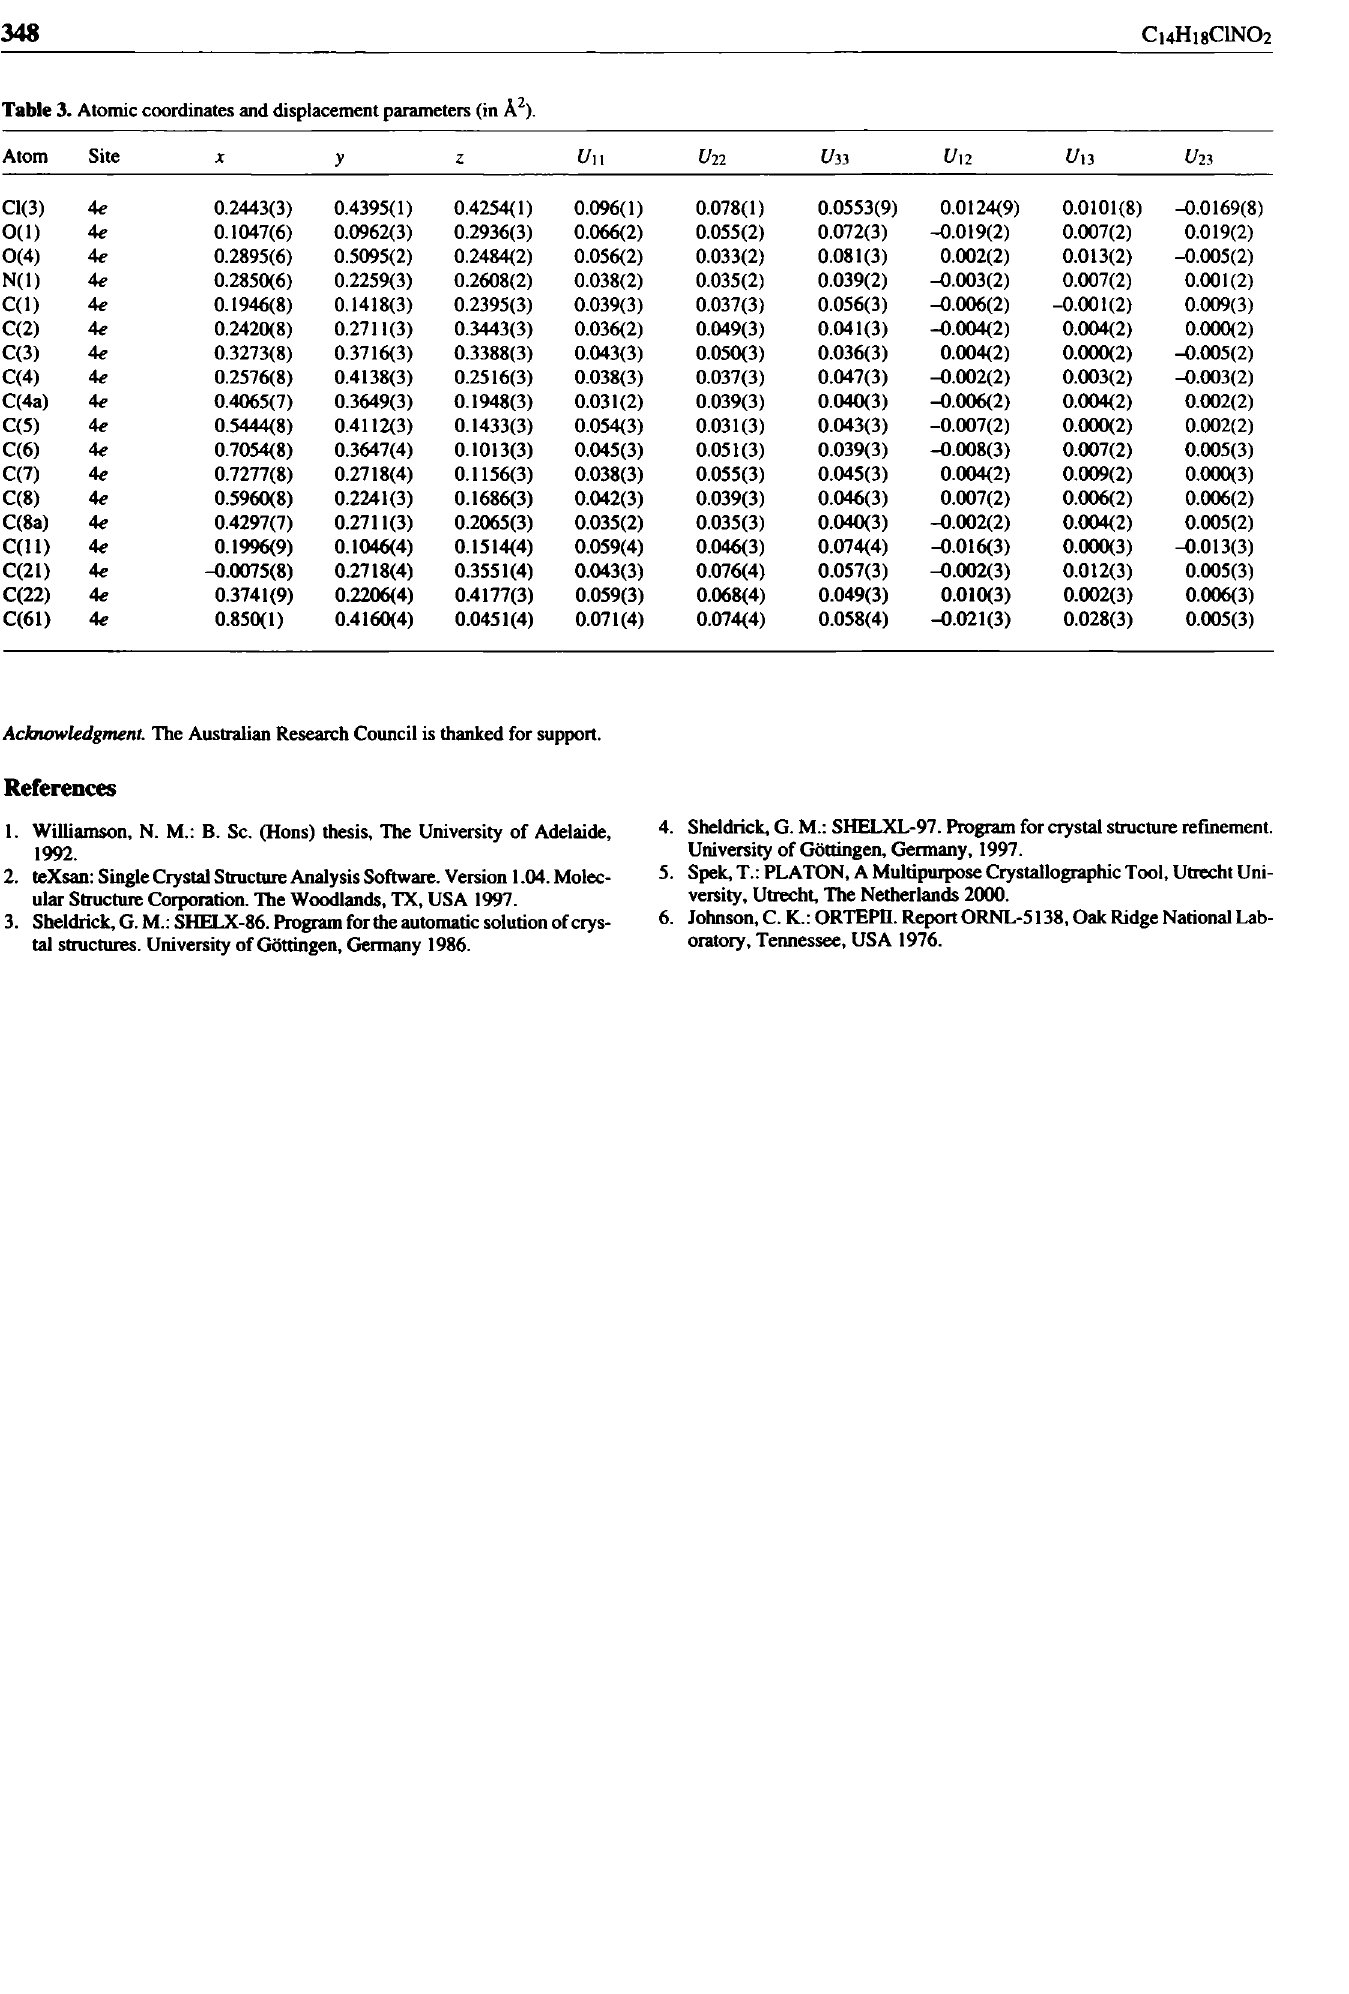
Table 3. Atomic coordinates and displacement parameters (in Ä 2